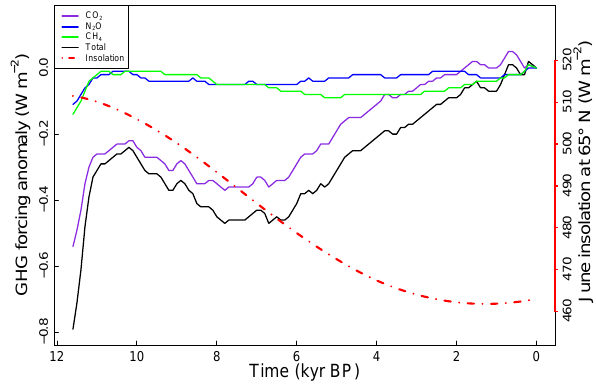
Figure 1. Evolution of greenhouse gas concentrations (GHGs) shown as the radiative forcing’s deviation from the preindustrial level (with solid lines corresponding to the left axis), and June inso- lation at 65 ◦ N derived from orbital configuration (with red line and the axis on the